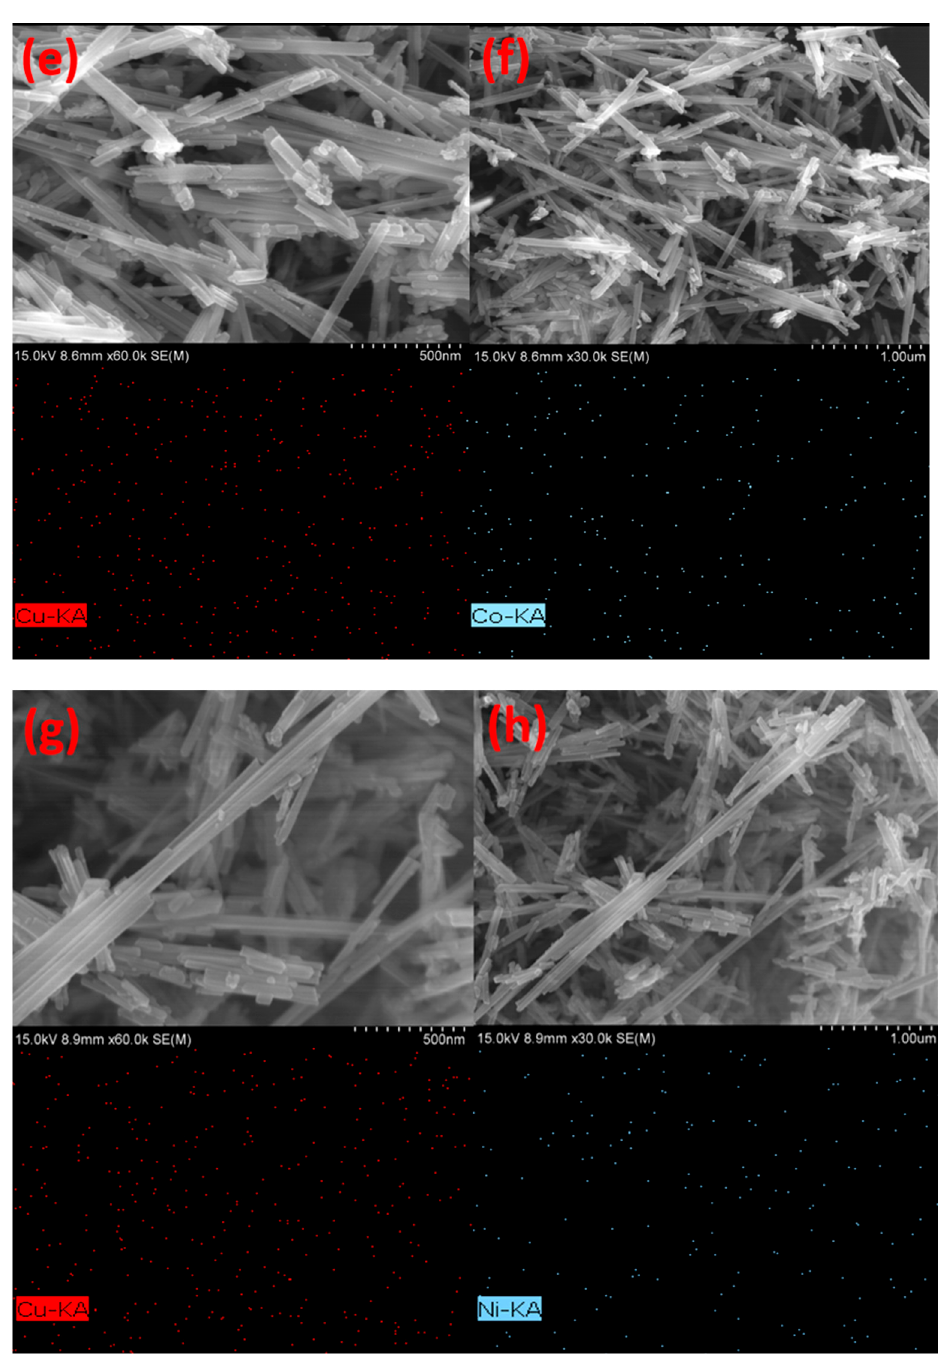
Figure 2. SEM-EDS images of the ( a ) α -MnO 2 nanowire, ( b ) 10CuO/ α -MnO 2 -400, ( c , d ) 10CuO-3Fe 2 O 3 / α -MnO 2 -400, ( e , f ) 10CuO-3Co 3 O 4 / α -MnO 2 -400, and ( g , h ) 10CuO-3NiO/ α -MnO 2 -400.